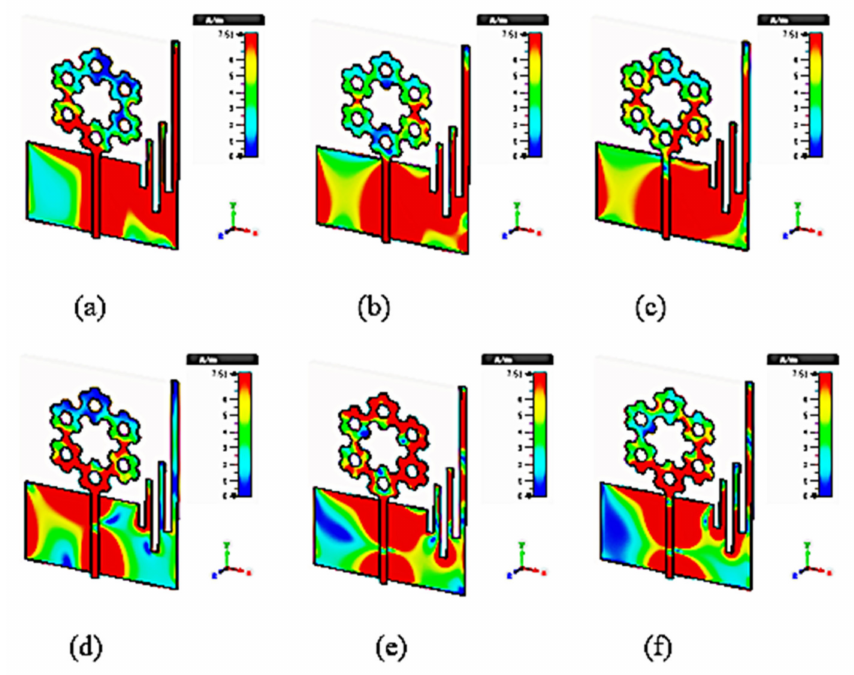
Figure 9. Surface current distribution at resonant frequencies: ( a ) 2.4 GHz; ( b ) 3.2 GHz; ( c ) 3.8 GHz; ( d ) 6.6 GHz; ( e ) 9.8 GHz; and ( f ) 10.57